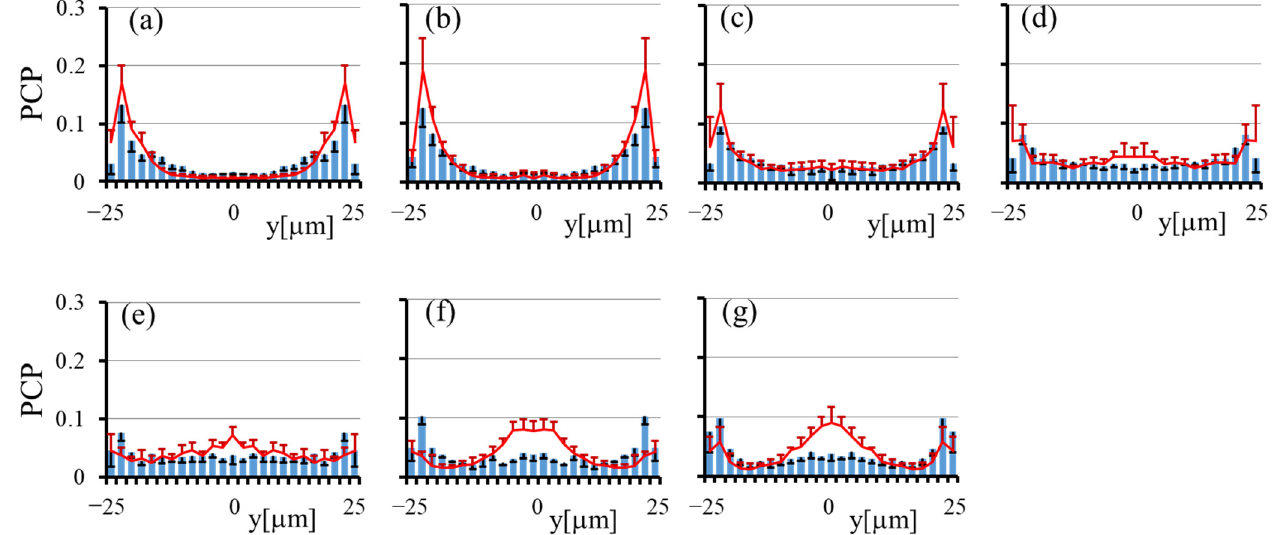
Figure 3. Particle concentration profiles across the channel width in the square channel: histogram for Ht = 20% and line graph for Ht = 40%, ( a ) z =1.9 µ m, ( b ) z = 5.7 µ m, ( c ) z = 9.5 µ m, ( d ) z = 13.3 µ m, ( e ) z = 17.1 µ m, ( f ) z = 20.9 µ m, and ( g ) z = 24.7 µ m. The error bar represents the standard deviation ( n = 5).